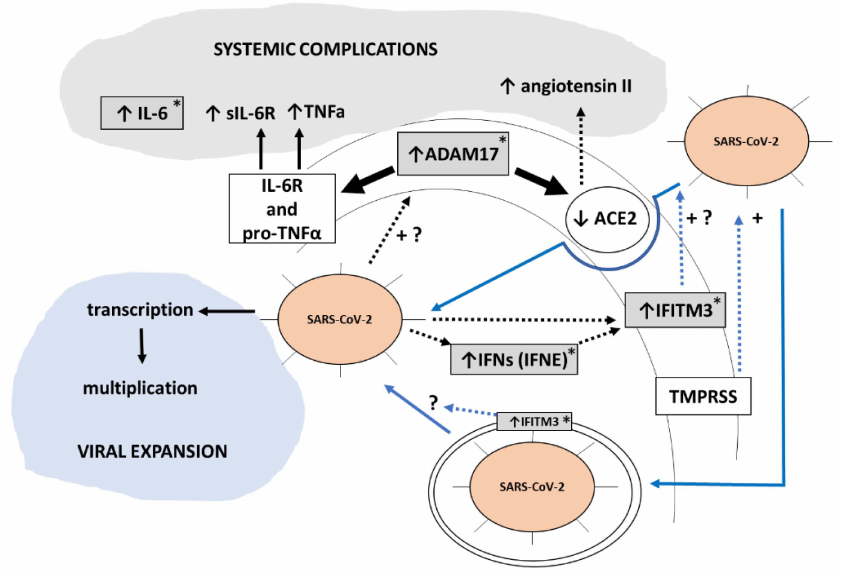
Figure 6. Scheme illustrating how gene expression changes observed in this work in PBCs used as sentinel cells could be related to and reflect COVID-19 severe evolution when extrapolate to clinically relevant tissues. Our results suggest that SARS-CoV-2 infection enhances ADAM17 gene expression and hence activity. Through increased proteolysis of its cell membrane substrates-Interleukin-6 receptor (IL- 6R), pro-tumor necrosis factor alfa (pro-TNFa) and ACE2-increased ADAM17 activity will result in higher circulating levels of sIL-6R (the soluble form of the IL-6R), TNFa, and angiotensin II. These changes, together with increased circulating IL-6 levels, will contribute to systemic COVID-19 complications. Additionally, our results are indicative of a SARS-CoV-2 infection dependent induction of interferons (IFN) and interferon downstream targets such as IFITM3, which can promote SARS-CoV-2 infectivity and hence viral expansion according to previous reports [51]. Boxes in grey are changes observed in the current work in PBCs at the gene expression level. Blue lines represent the two main entry routes for SARS-CoV-2 into cells. Discontinuous lines indicate an indirect effect. +, enhancement effect; +?, suggested enhancement effect. Asterisks denote genes/proteins whose expression is elevated in COVID-19 patients with obesity, according to our results.